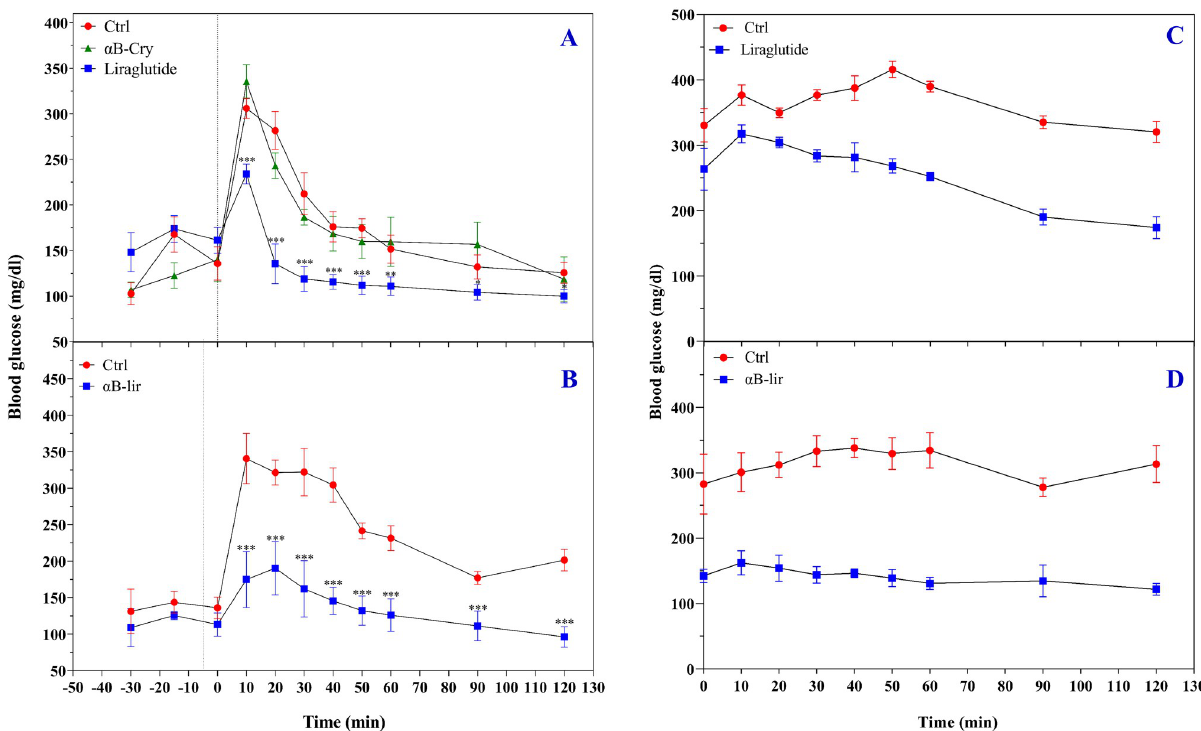
Fig 7. The glucose-lowering activity of LPP and α B-lir. The glucose-lowering effects (IPGTT) of LPP ( A ) and α B-lir ( B ) were studied. A single-dose of the LPP (200 μ g/kg body weight) and the α B-lir hybrid protein (1.4 mg/kg body weight) was injected to the mice and the blood glucose concentration was measured during 120 minutes [46]. The concentration of injected glucose was 1.5 mg/g body weight of the normal mice, and the injection was done at time zero. In the case of α B-lir, the blood glucose level was monitored after 24 hours of the initial injection. The blood glucose levels of STZ-induced diabetic mice (n = 6) were also measured after a single-dose, 200 μ g/kg and 1.4 mg/kg body weight, respectively, for the injection of the LPP ( C ) and α B-lir ( D ). The data were significantly different from the control group (p < 0.05).